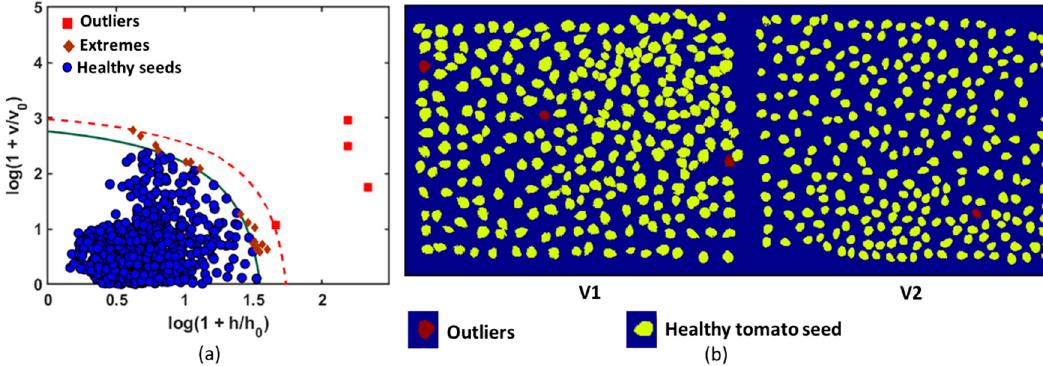
Figure 7. ( a ) Application of data-driven soft independent modeling of class analogy (DD-SIMCA) model calibration to identify for the target group authentication. The solid green curve limits the acceptance area ( α = 0.001) and the dashed red curve limits the outlier area ( γ = 0.05); ( b ) Healthy tomato seed identification using the calibration model for two varieties.